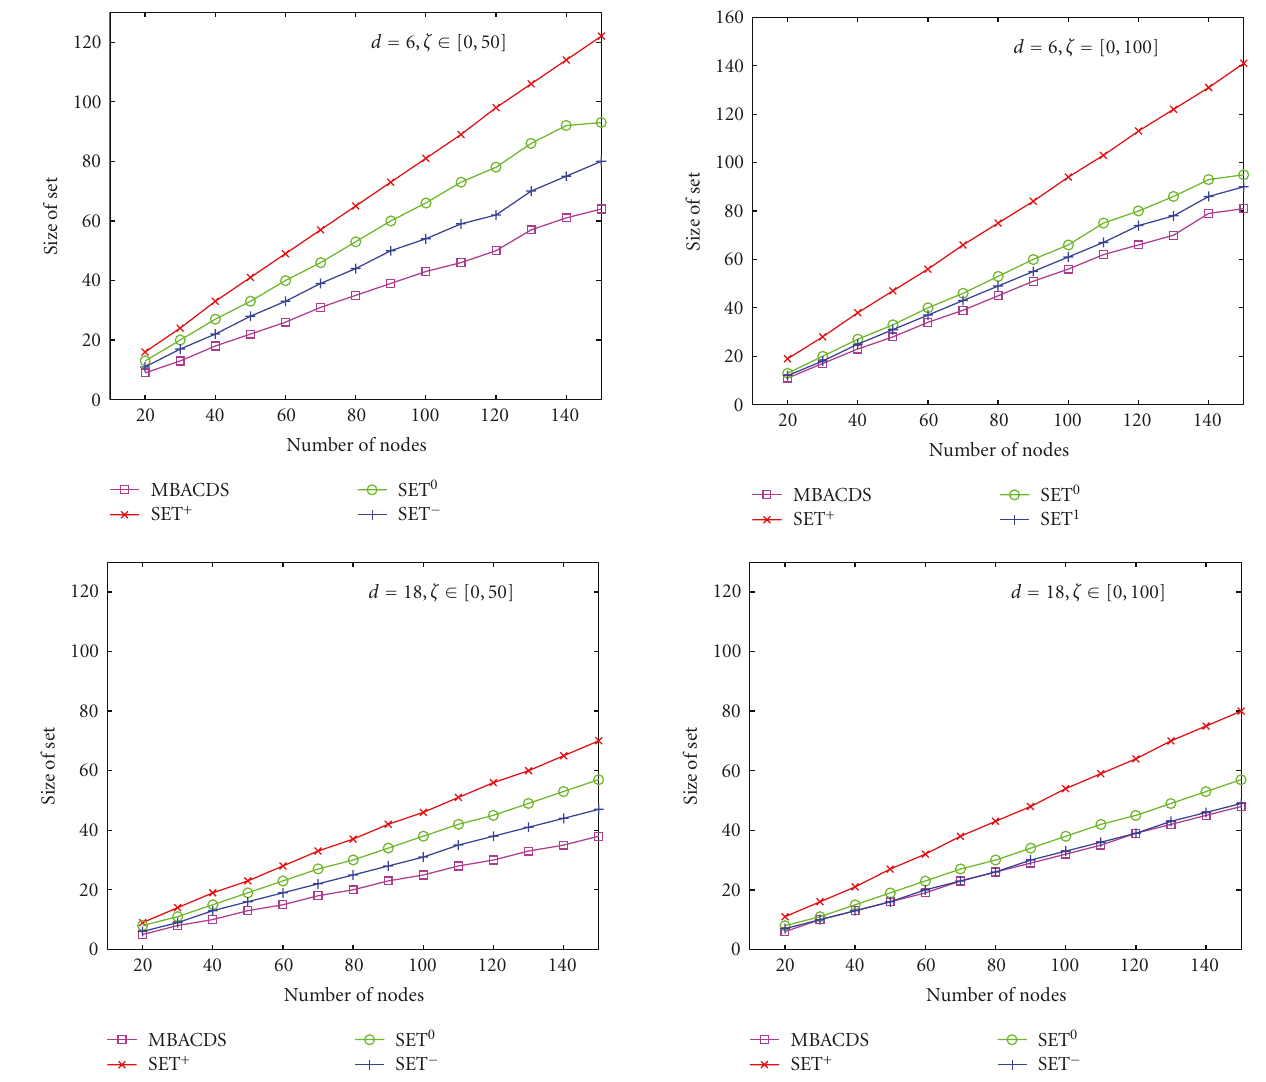
Figure 13: The size of constructed sets with di ff erent ζ and d